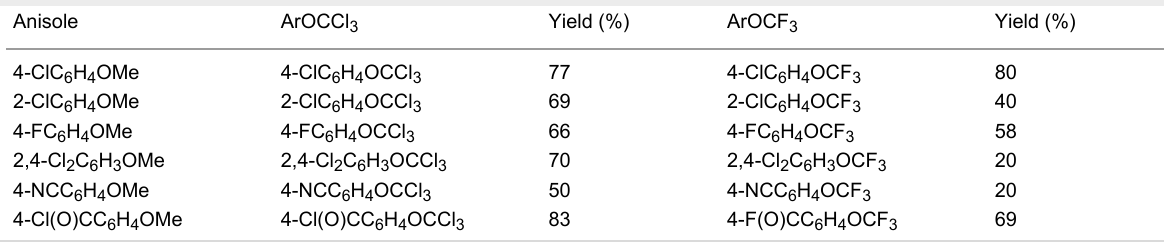
Table 2: Synthesis of ArOCF 3 compounds starting from substituted anisoles.